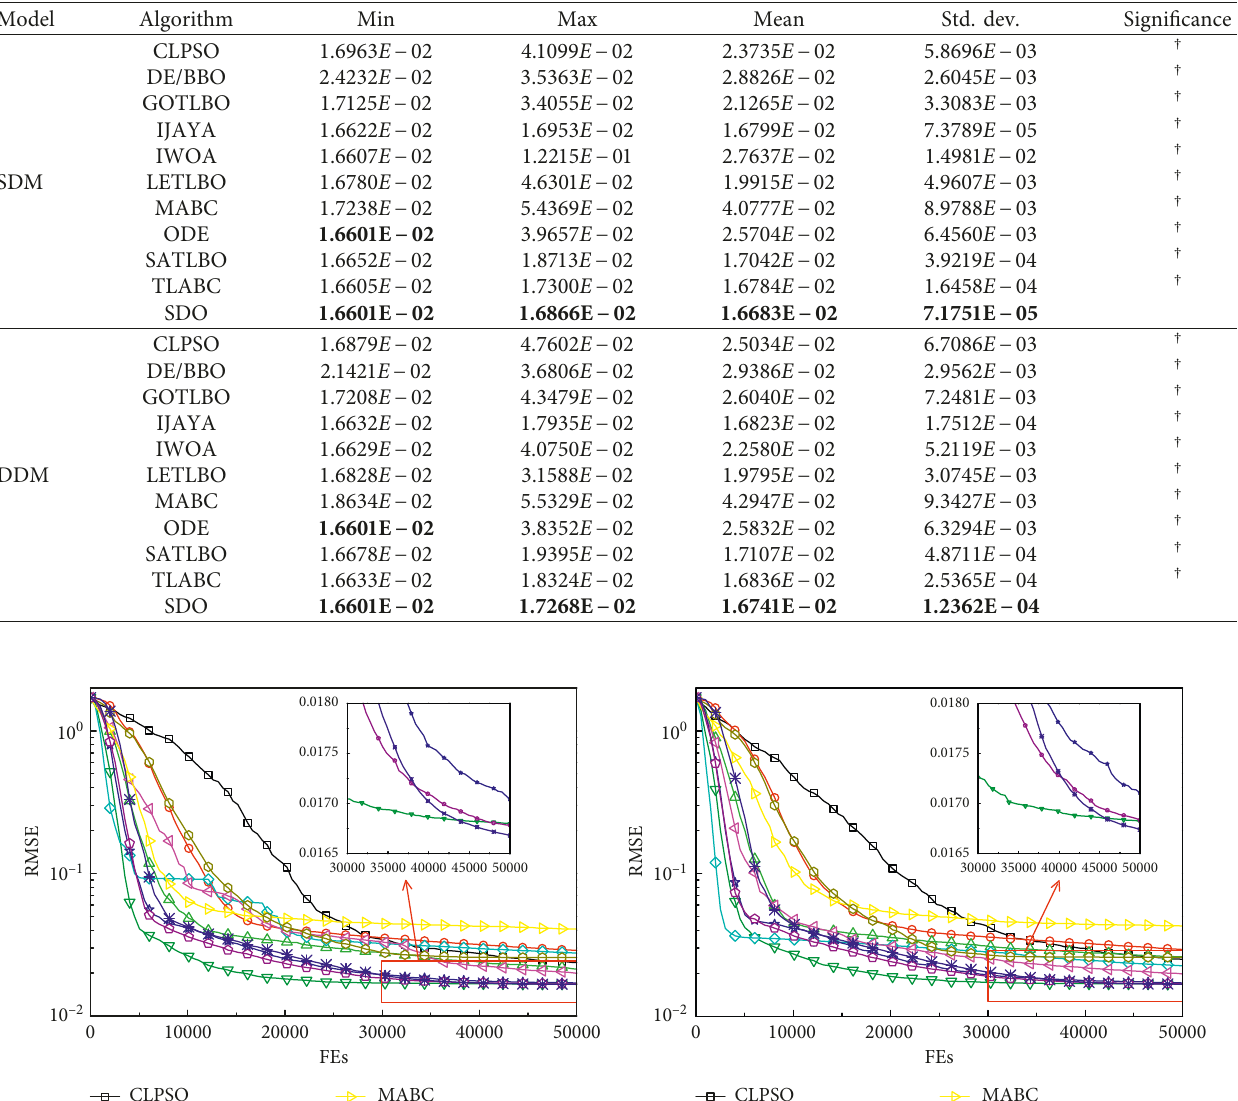
Table 12: Experimental results on the STP6-120/36 module.